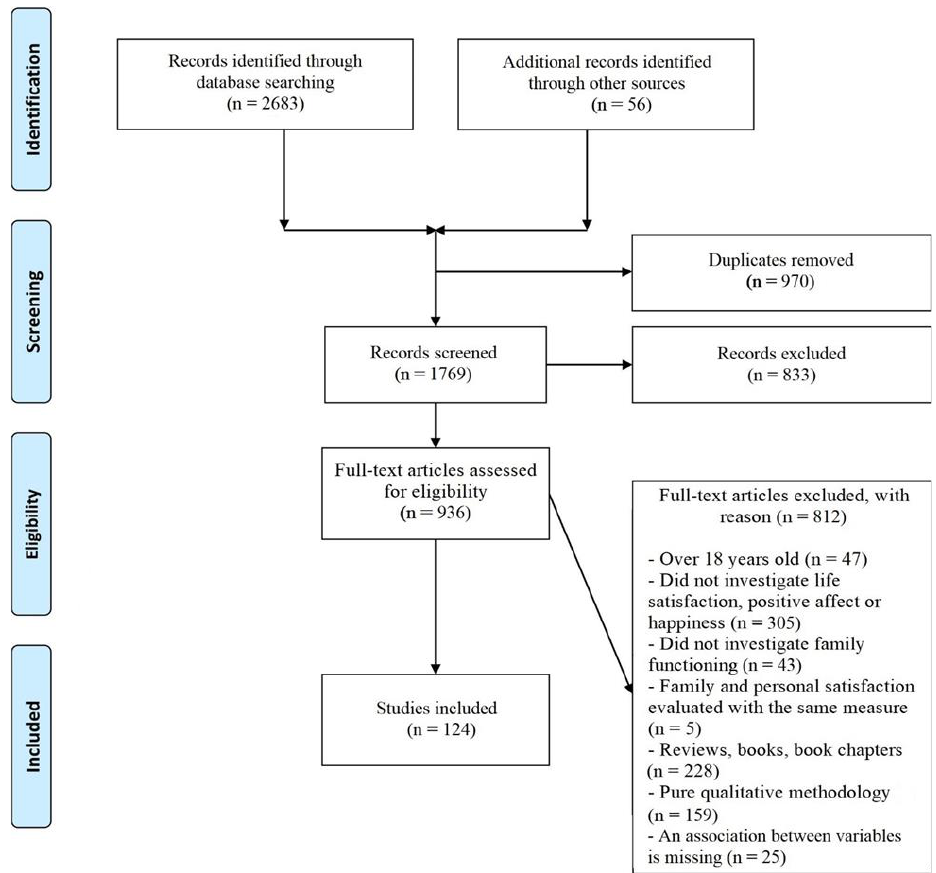
Figure 1. PRISMA flowchart of the study selection .